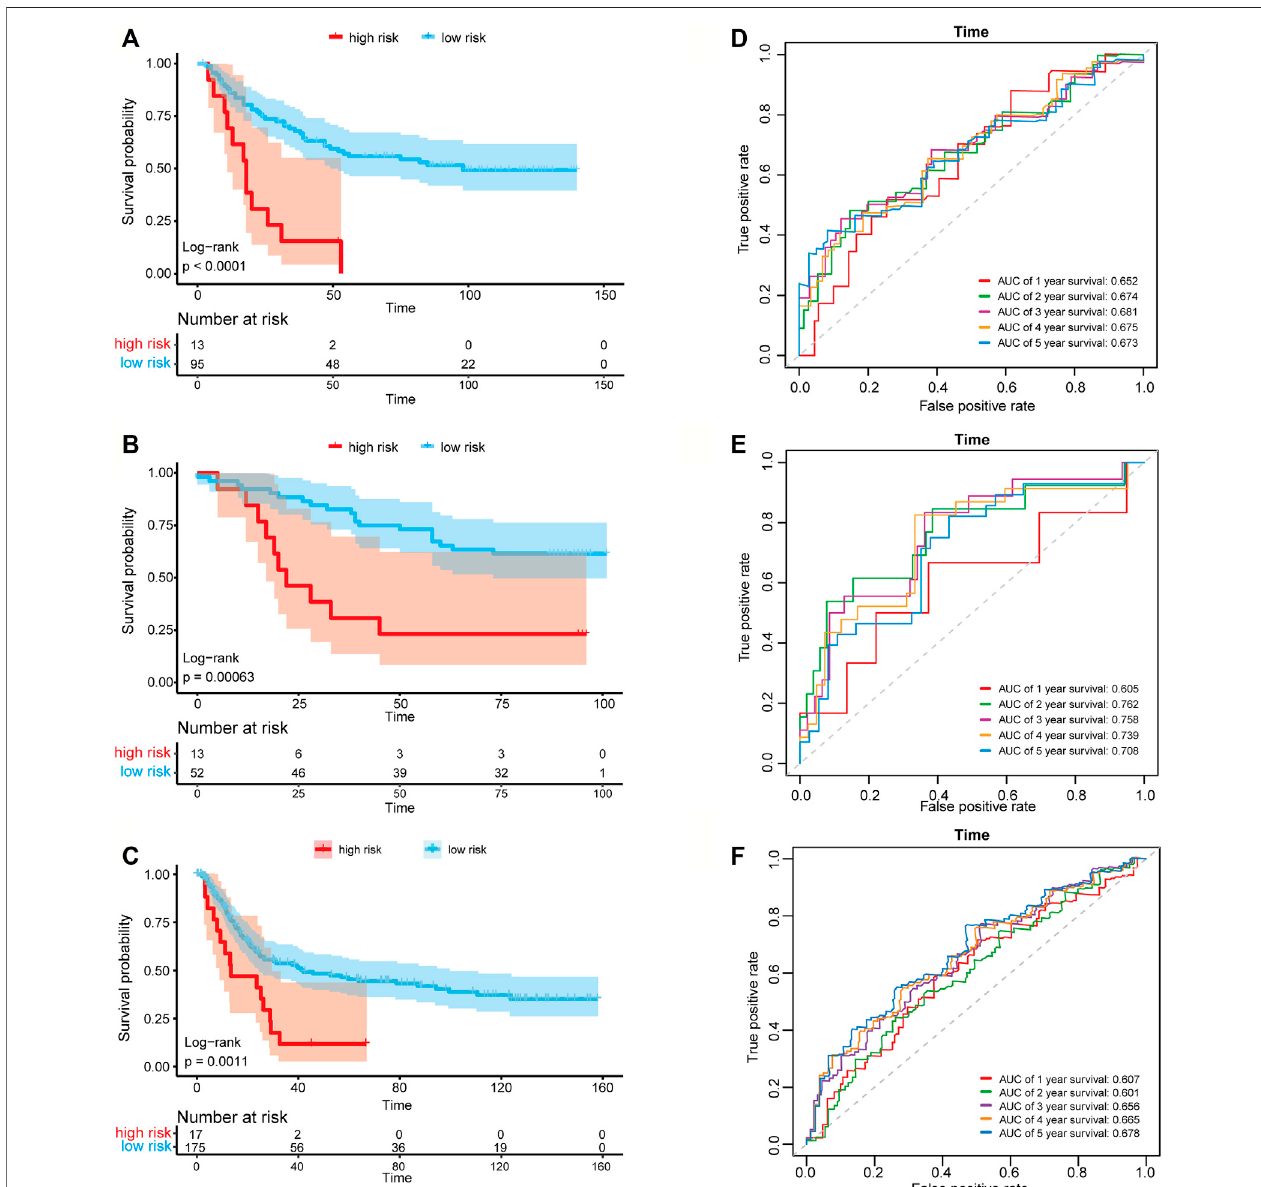
FIGURE 4 | Kaplan-Meier plots and time-dependent ROC curves of the risk score model in three GEO data sets. Kaplan-Meier survival curve shows the overall survival of high-risk and low-risk groups in (A) GSE26901 data set, (B) GSE13861 data set and (C) GSE15459 data set. ROC curve plots for predicting the 1 – 5 years survival rate in (D) GSE26901 data set and (E) GSE13861 data set and (F) GSE15459 data set.